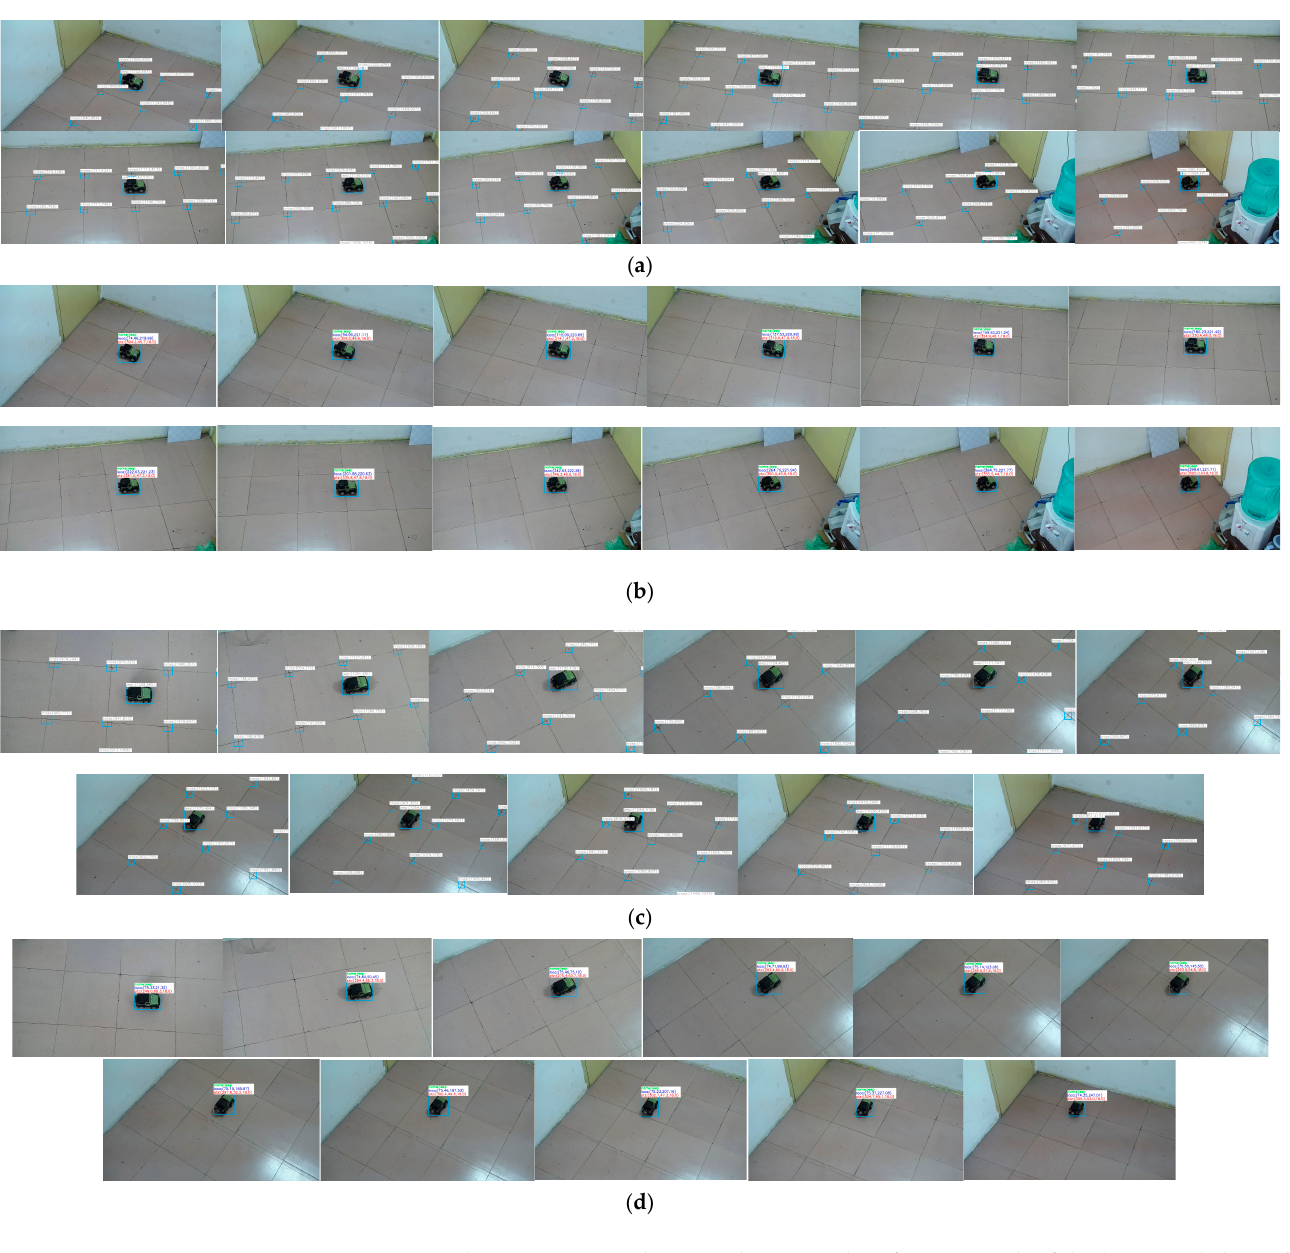
Figure 17. Final recognition result. ( a ) Preliminary identification result of the horizontal channel. ( b ) Final identification result of the horizontal channel. ( c ) Preliminary identification result of the vertical channel. ( d ) Final identification result of the vertical channel.